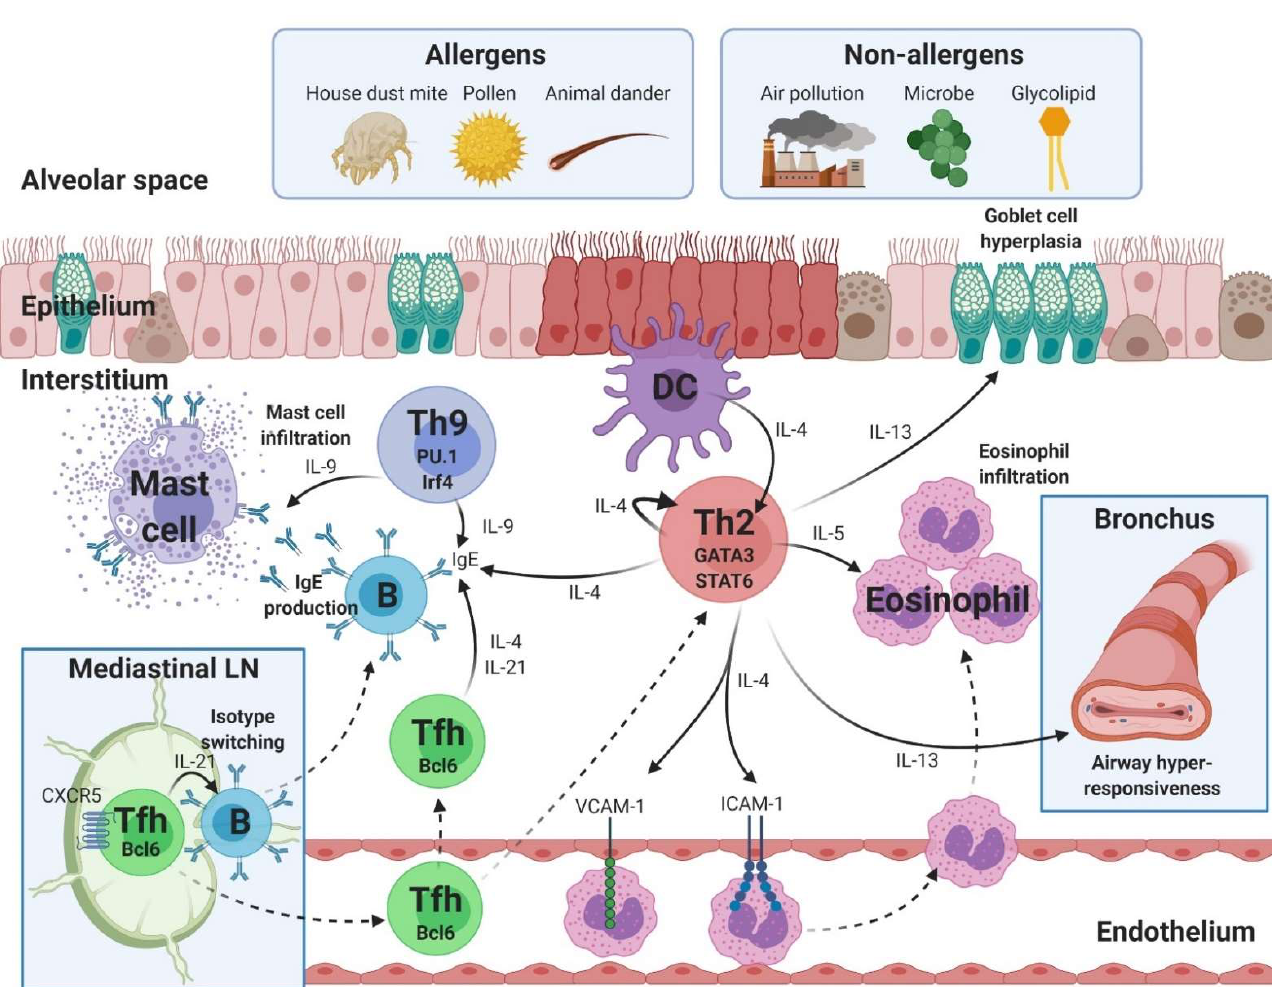
Figure 1. Pathogenesis of eosinophilic asthma mediated by T helper (Th)2, Th9 and T follicular helper (Tfh) cells. The development of eosinophilic asthma is associated with the Th2, Th9 and Tfh subtypes of CD4 + T cells. Th2 cells play roles in eosinophilic infiltration, goblet cell hyperplasia, airway hyperresponsiveness, immunoglobulin (Ig)E production, and upregulation of endothelial molecules, including vascular cell adhesion molecule (VCAM)-1 and intercellular adhesion molecule (ICAM)-1. GATA-binding protein 3 (GATA3) and signal transducer and activator of transcription (STAT)6 are transcriptional factors in Th2 cells. Th9 cells mediate mast cell infiltration and IgE production. PU and Irf4 are transcriptional factors in Th9 cells. Bcl6-expressing Tfh cells mediate isotype switching and IgE production. Text color: Black, cytokine. LN, lymph node; DC, dendritic cell; IL, interleukin; Irf4, interferon regulatory factor 4; CXCR5, C-X-C chemokine receptor type 5. Figure created using BioRender.com (accessed on 6 September 2021).